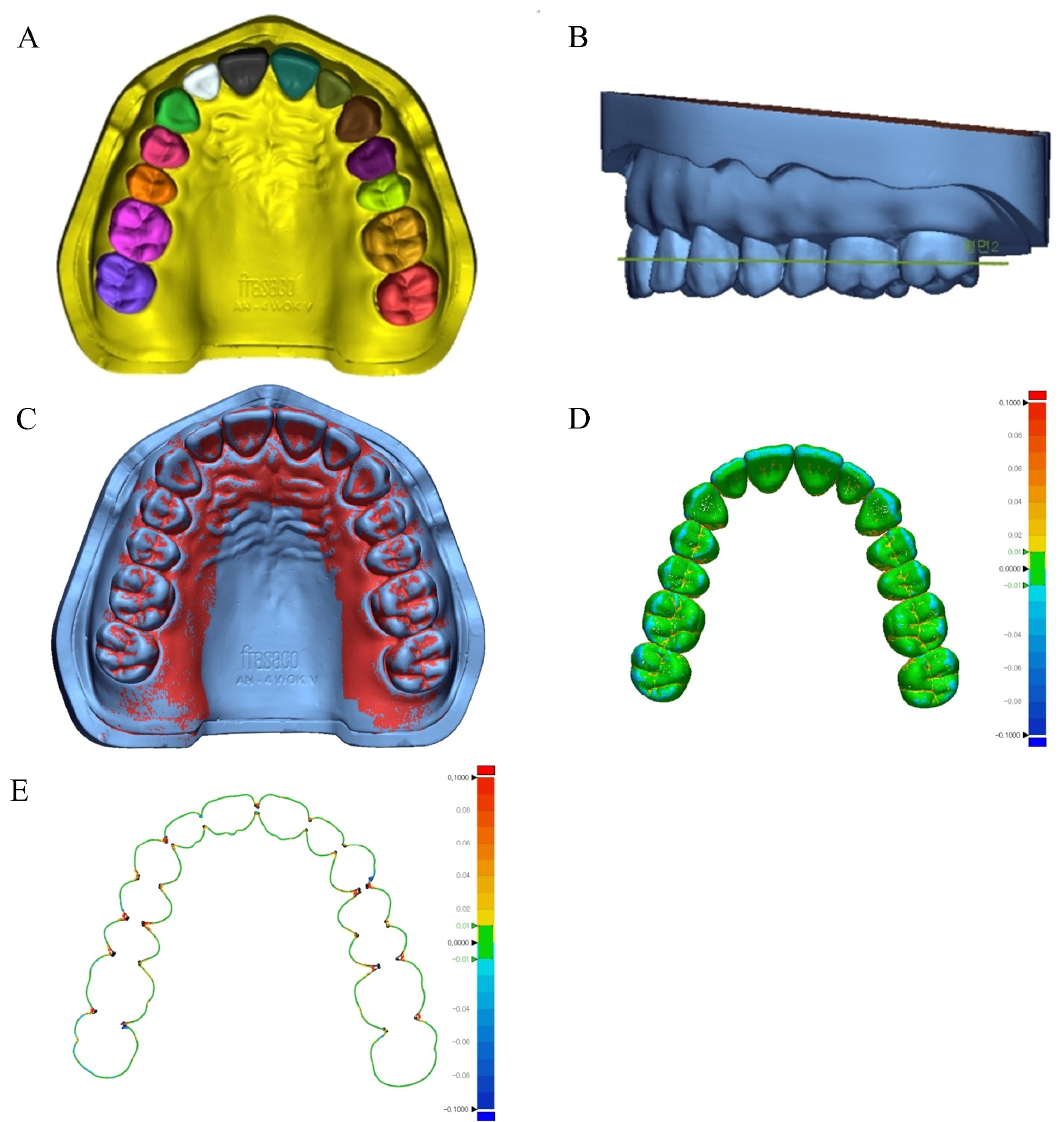
Figure 3. Three-dimension (3D) analysis procedure. ( A ) Tooth segmentation, ( B ) virtual plane for horizontal displacement, ( C ) superimposition of CRM and CTM, ( D ) 3D displacement, and ( E ) horizontal displacement.